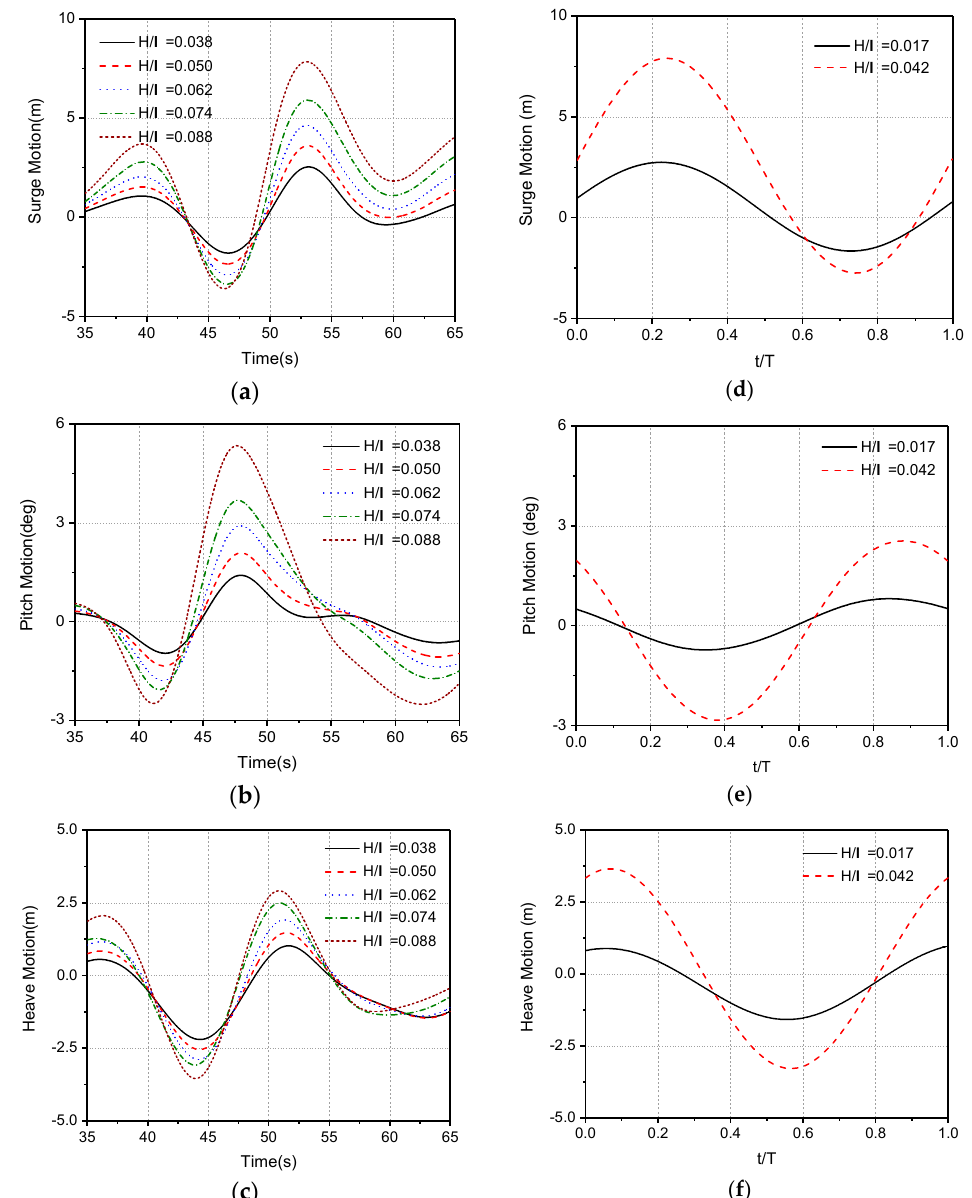
Figure 18. 3 DOF motions under different focused waves and regular waves: ( a ) Surge motion under focused wave (Cases 1 to Case 5) ( b ) Pitch motion under focused wave (Case 1 to Case 5) ( c ) Heave motion under focused wave (Cases 1 to Case 5) ( d ) Surge motion under regular wave (Cases 6 and Case 10) ( e ) Pitch motion under regular wave (Case 6 and Case 10) ( f ) Heave motion under regular wave (Case 6 and Case 10). To complement the study of wave steepness and platform dynamic motion responses, the peak values of three DoF motions are analysed from t = 35 s to 65 s (e.g., ±15 s near focused time); the results are summarized in Figure 19. Before the wave steepness H / λ = 0.074, we can see a linear relationship between H / λ vs. maximum motion response, revealing that floating platform dynamic response follows a linear variation with the increase of wave steepness. However, above H / λ = 0.074, the sudden changes of slop for H / λ vs. maximum motion lines can be observed, due to the presence of nonlinear phenomena such as the extra excitation induced by wave overtopping.